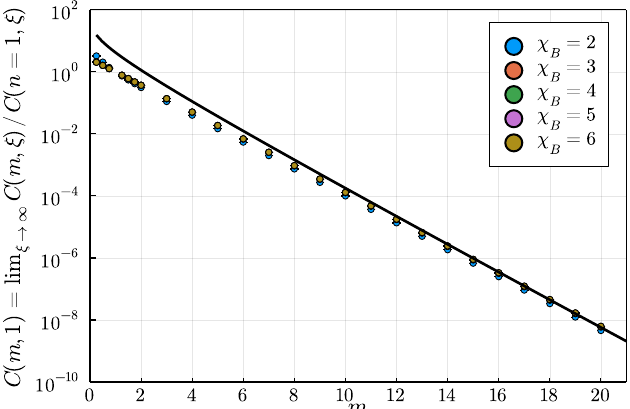
( m , n ) = lim ( m , ξ ) / C ( n , ξ ) for all ξ →∞ C C at different values of m . The reference is fixed to B